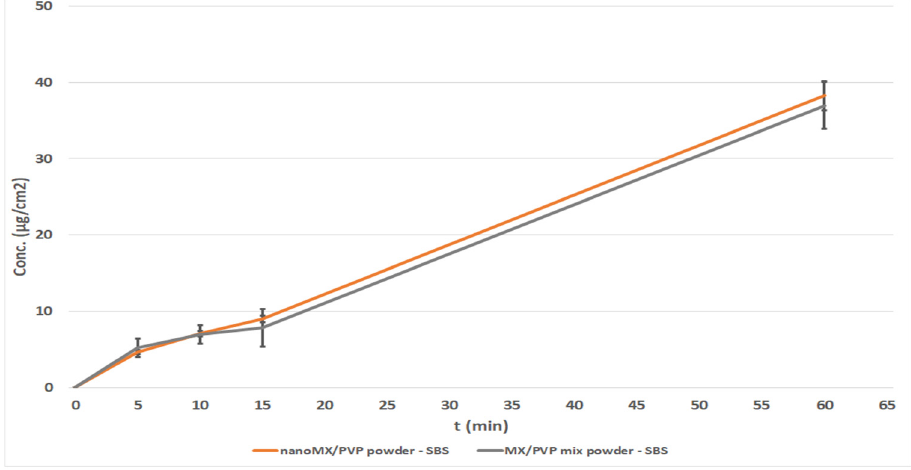
Figure 6. In vitro permeability of intranasal powders on Franz and Side-Bi-Side diffusion systems.